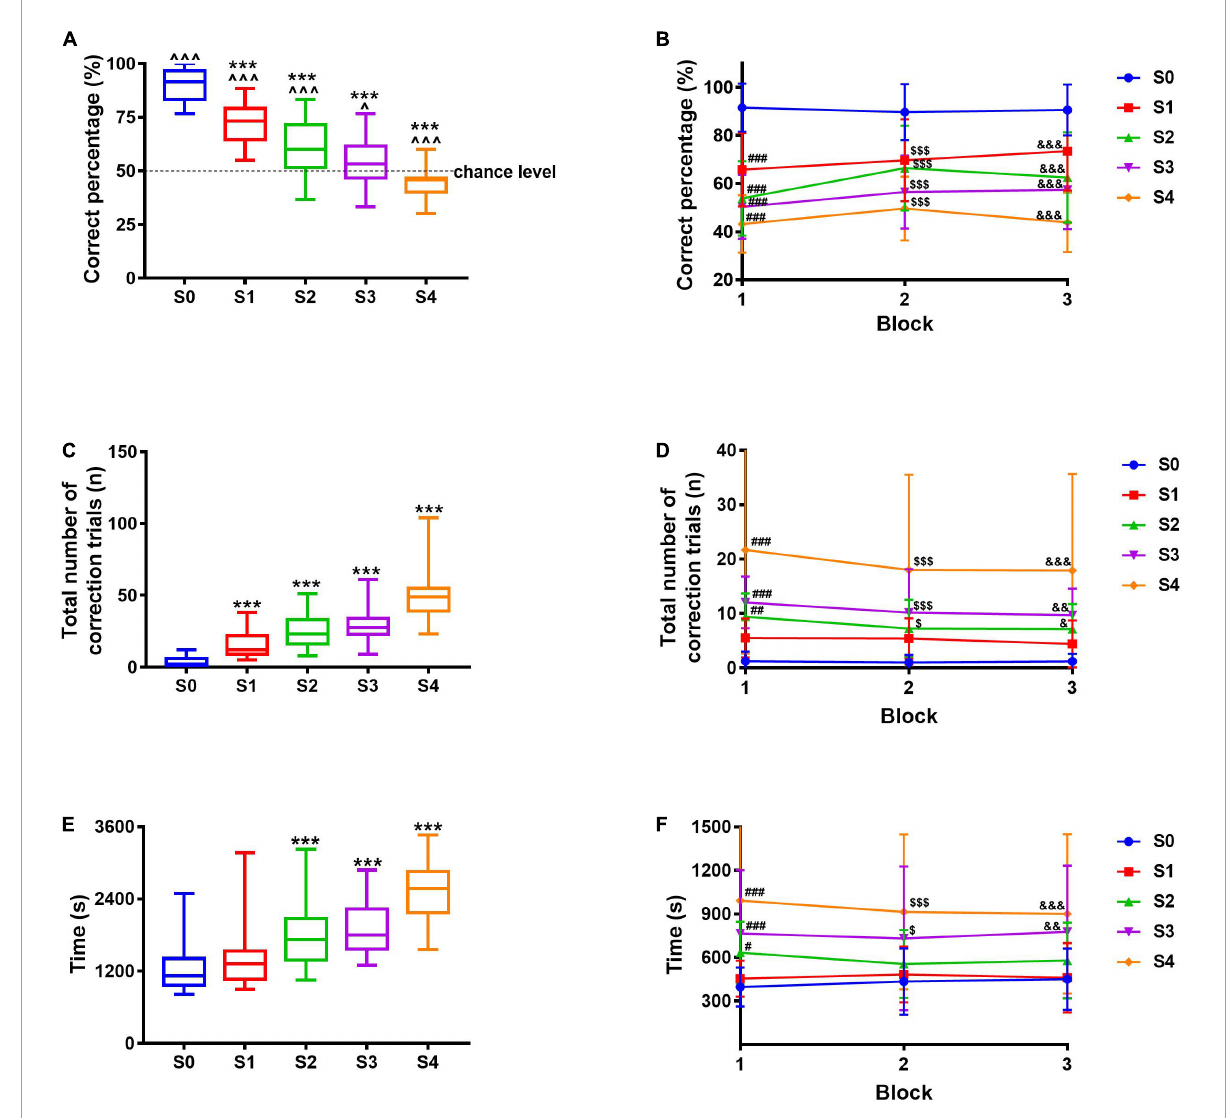
FIGURE3 Pattern separation evaluation paradigm using different images. (A) Correct percentage. (B) Correct percentage in each block. (C) The total number of correction trials. (D) The total number of correction trials in each block. (E) The total time required to complete 30 trials. (F) Time required to complete every 10 trials. Data are presented as the mean ± SD ( n = 30–31). ˆ p < 0.05 and ˆˆˆ p < 0.001 compared with chance level, one-sample t -test. *** p < 0.001 compared with the S0 group, one-way ANOVA followed by the post hoc Dunnett’s t -test. # p < 0.05, ## p < 0.01, and ### p < 0.001 compared with the S0 group during Block 1; $ p < 0.05 and $$$ p < 0.001 compared with the S0 group during Block 2; & p < 0.05, && p < 0.01, and &&& p < 0.001 compared with the S0 group during Block 3, two-way repeated-measures ANOVA followed by Tukey’s t